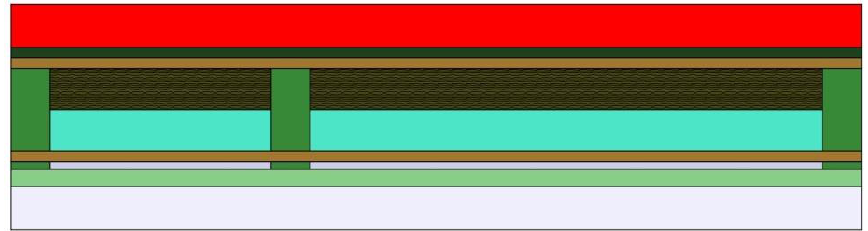
Figure 6. Completion of the design of the light-frame timber masonry. The color variation displays the different materials used based on the Table 3 (masonry board, studs, insulation, humidity membrane, OSB, etc).